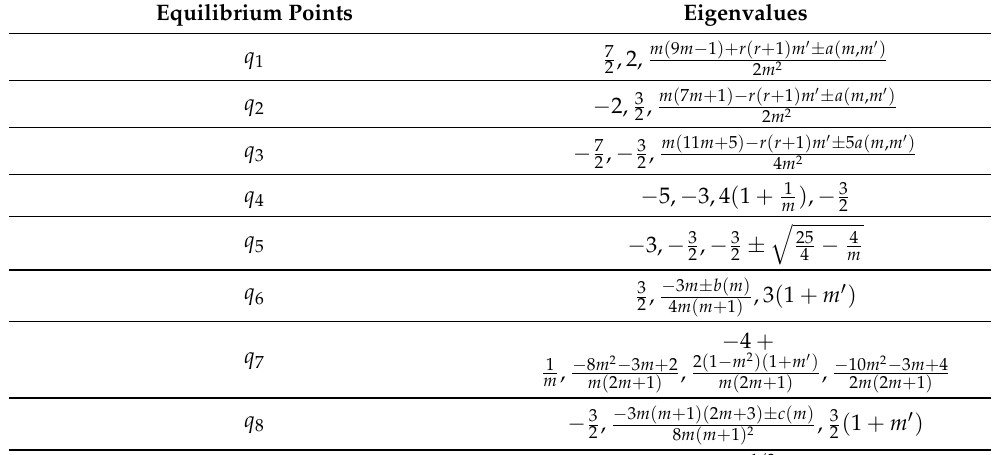
Table 6. Eigenvalues of equilibrium